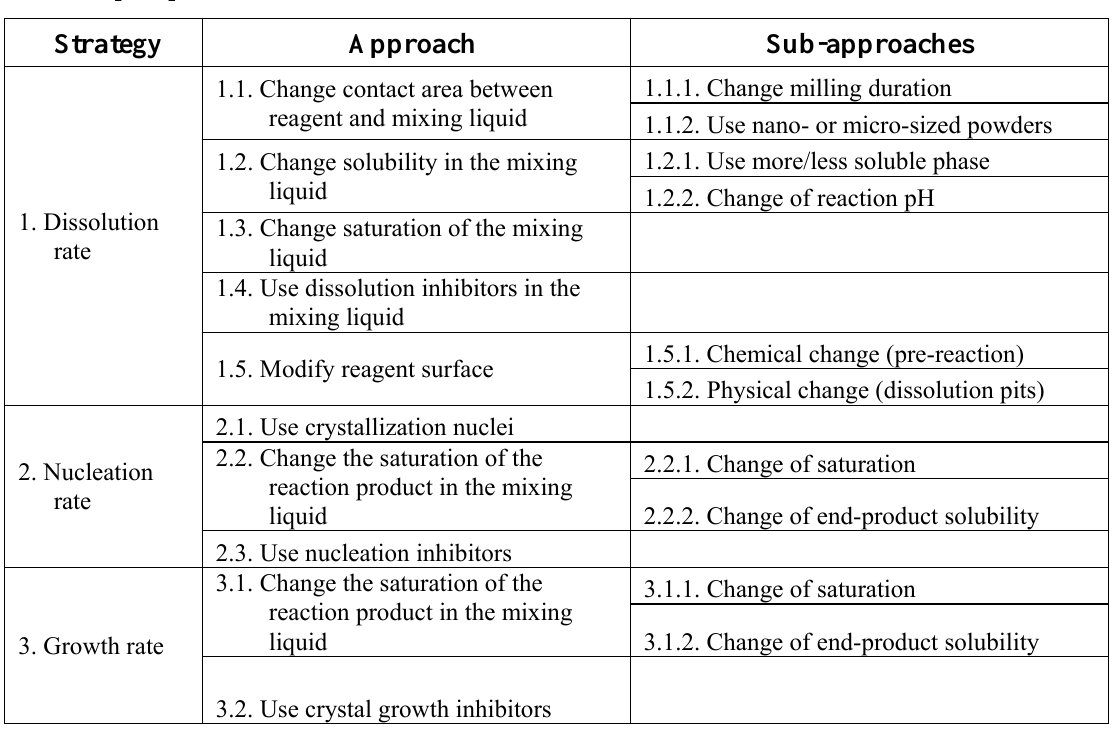
Table 3. List of strategies and approaches to modify reactivity of calcium orthophosphate cements